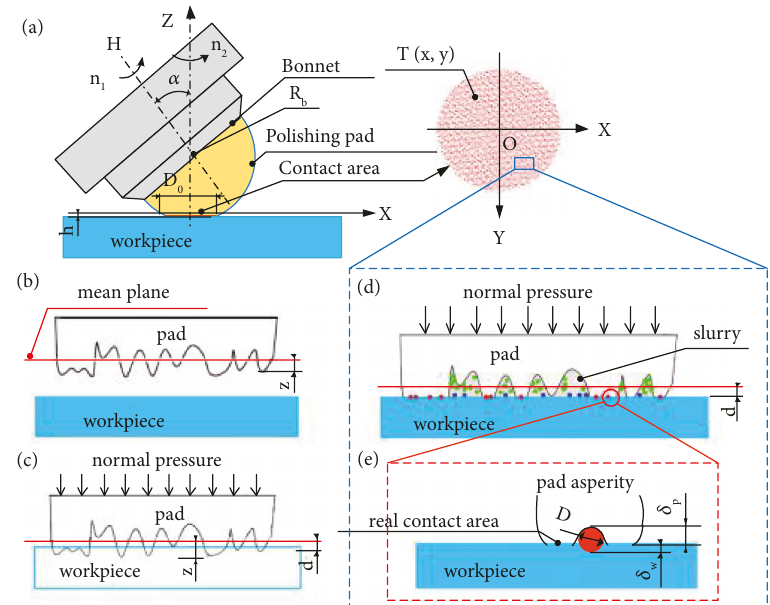
Figure 4: Microtheoretical model of material removal in BP